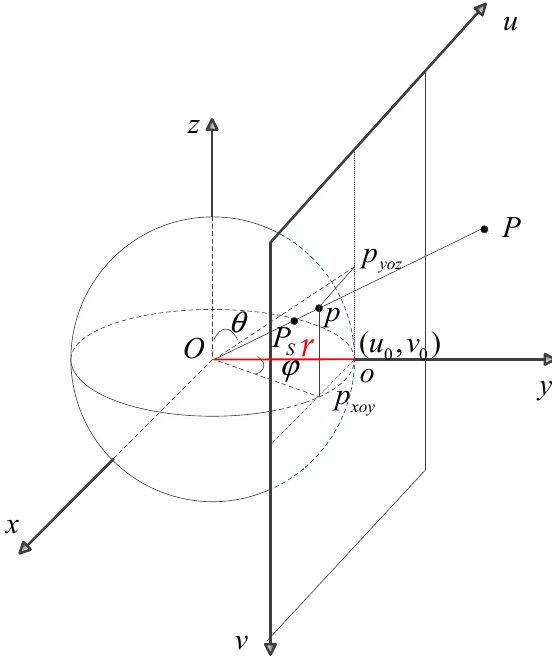
Figure 3. Spherical projection model.